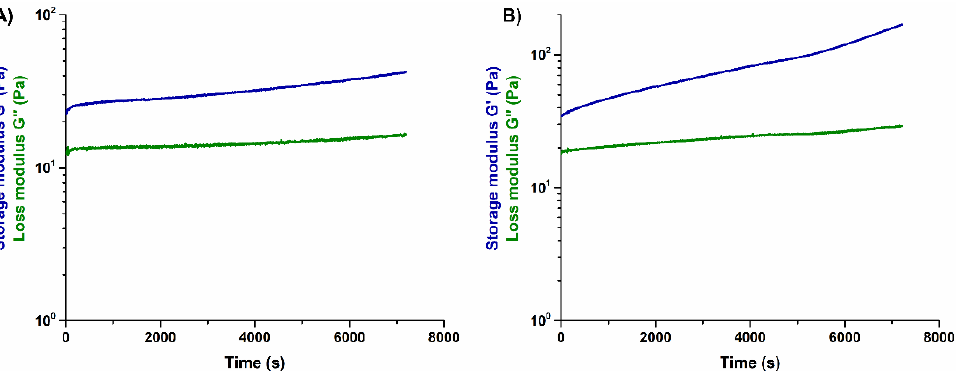
Figure 2. Visco-elastic properties of GEN-Coll solutions containing 0.1 wt.% ( A ) and 0.2 wt.% ( B ) of genipin, at 10 °C.